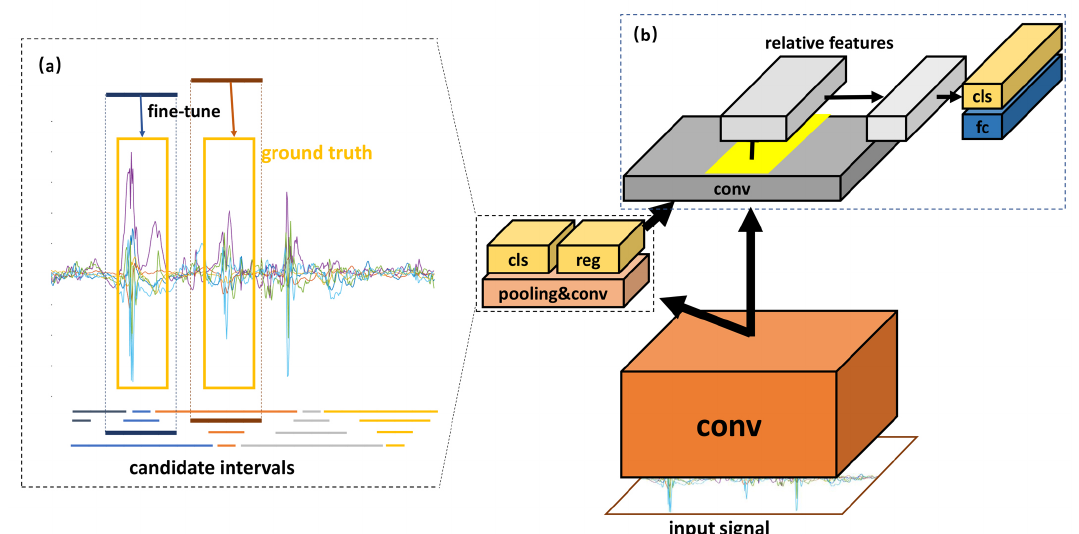
Figure 3. The flowchart of non-periodic activity with complex motion states (NP_CMS) activity detection and recognition. ( a ) Interval generation: the bottom lines with different colors and lengths represent the candidate anchors that we preset. The bold lines show the candidate interval. This step picks out the candidate interval from the anchors by using cls and fine-tunes it with reg to better match the ground truth. ( b ) Interval-based activity recognition: the yellow part of the gray feature map represents the relative features of the second candidate interval. The relative features are extracted from the feature map and then pooled into a fixed size. Finally, the fixed-size features are entered into the fully connected layer and softmax layer to produce the final recognition result.